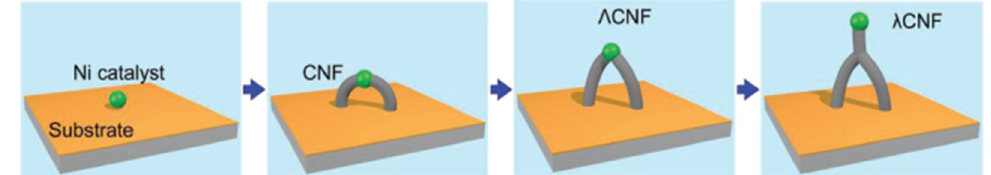
Figure 10. Schematic growth of lambda-shaped CNFs (not to scale). Reproduced with permission from [122], © 2019 WILEY-VCH Verlag GmbH & Co. KGaA, Weinheim.